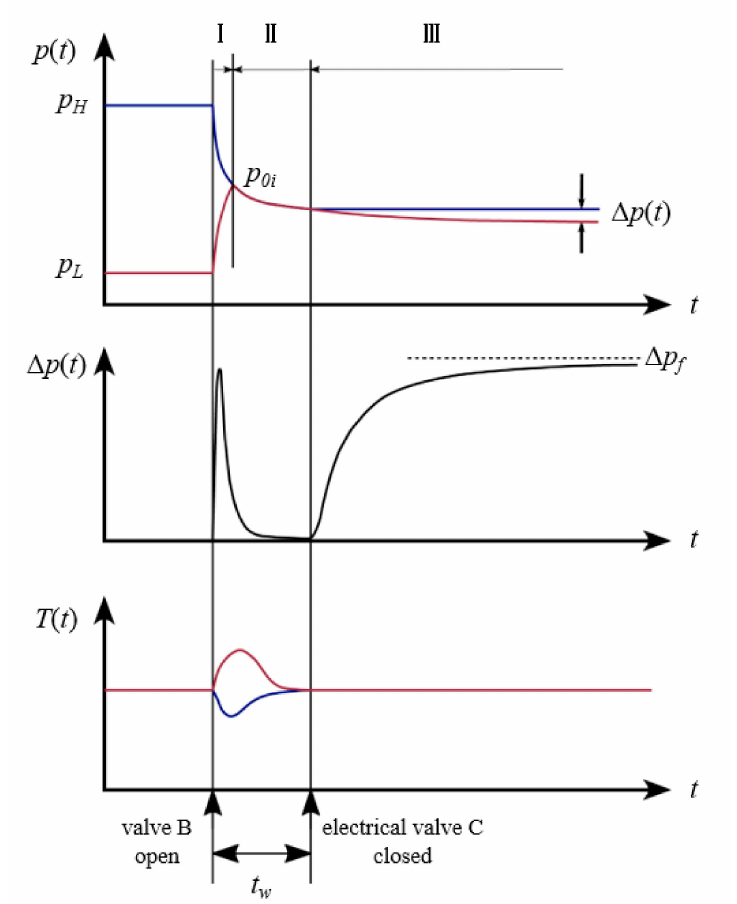
Figure 4. Graphs of the pressure p ( t ) of the reference chamber and sample chamber, the pressure di ff erence signal ∆ p ( t ) measured by the di ff erential pressure transducer, and the gas temperature T ( t ) in the